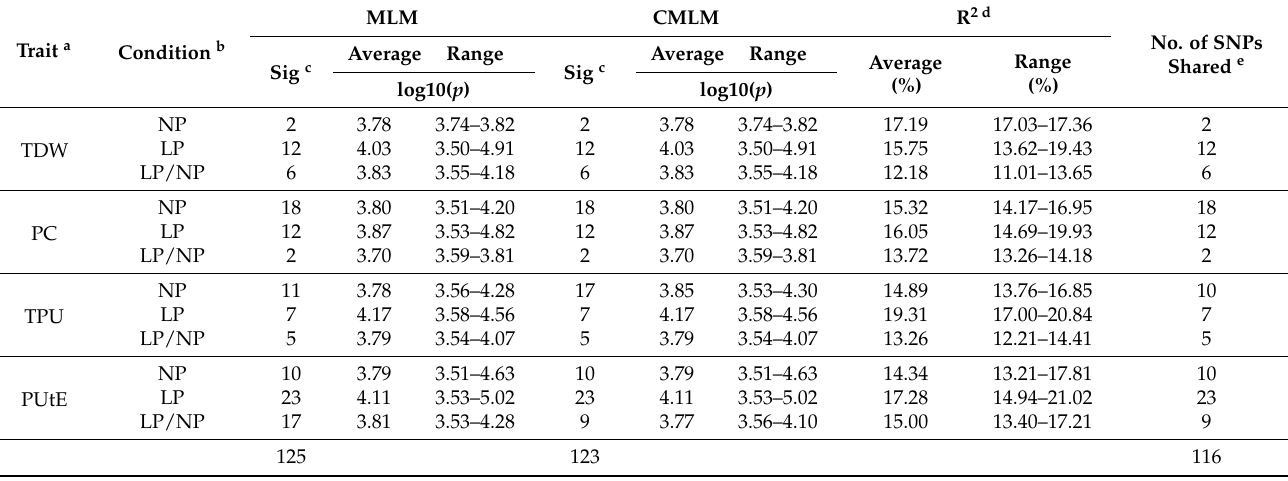
Table 2. Genome-wide association study for total dry weight (TDW), P concentration (PC), total P uptake (TPU), and P utilization efficiency (PUtE) studied using a mixed linear model (MLM) and compressed mixed linear model (CMLM).